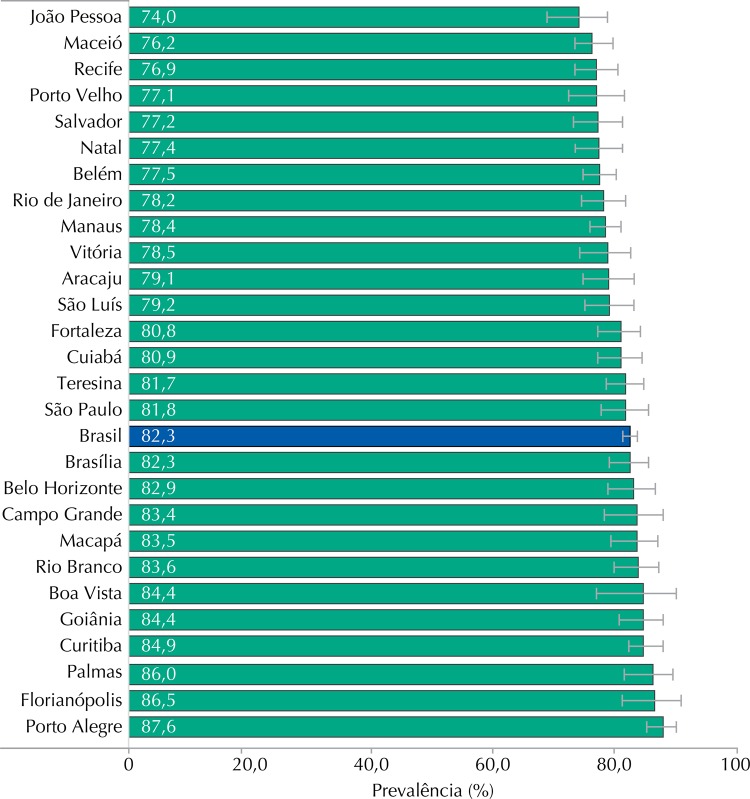
Prevalência de uso de método contraceptivo na última relação sexual, segundo as capitais. ERICA, Brasil, 2013-2014.